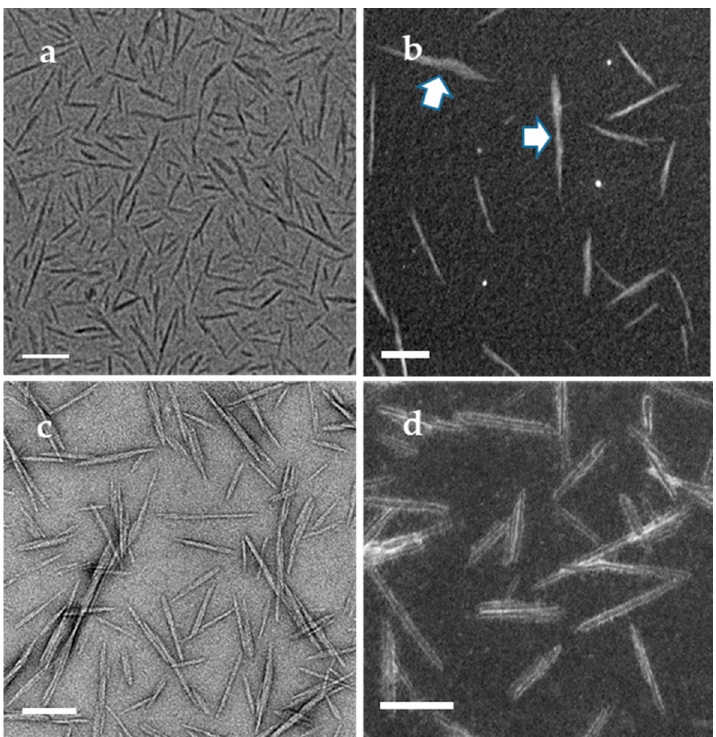
Figure 3. ( a ) under-focused ( − 3 µm) BF-TEM and ( b ) ADF-STEM images of unstained CNCs; ( c ) BF-TEM and ( d ) ADF-STEM image of stained CNCs. Scale bars: 100 nm.